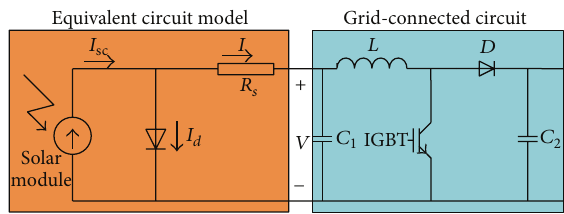
Figure 6: The equivalent circuit model and grid-connected circuit of PV.